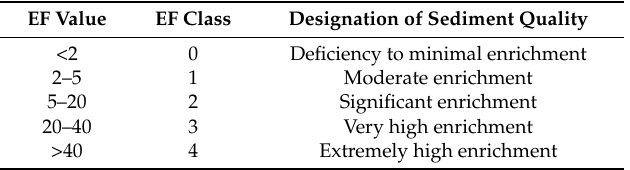
Table 1. Contamination categories based on EF values and